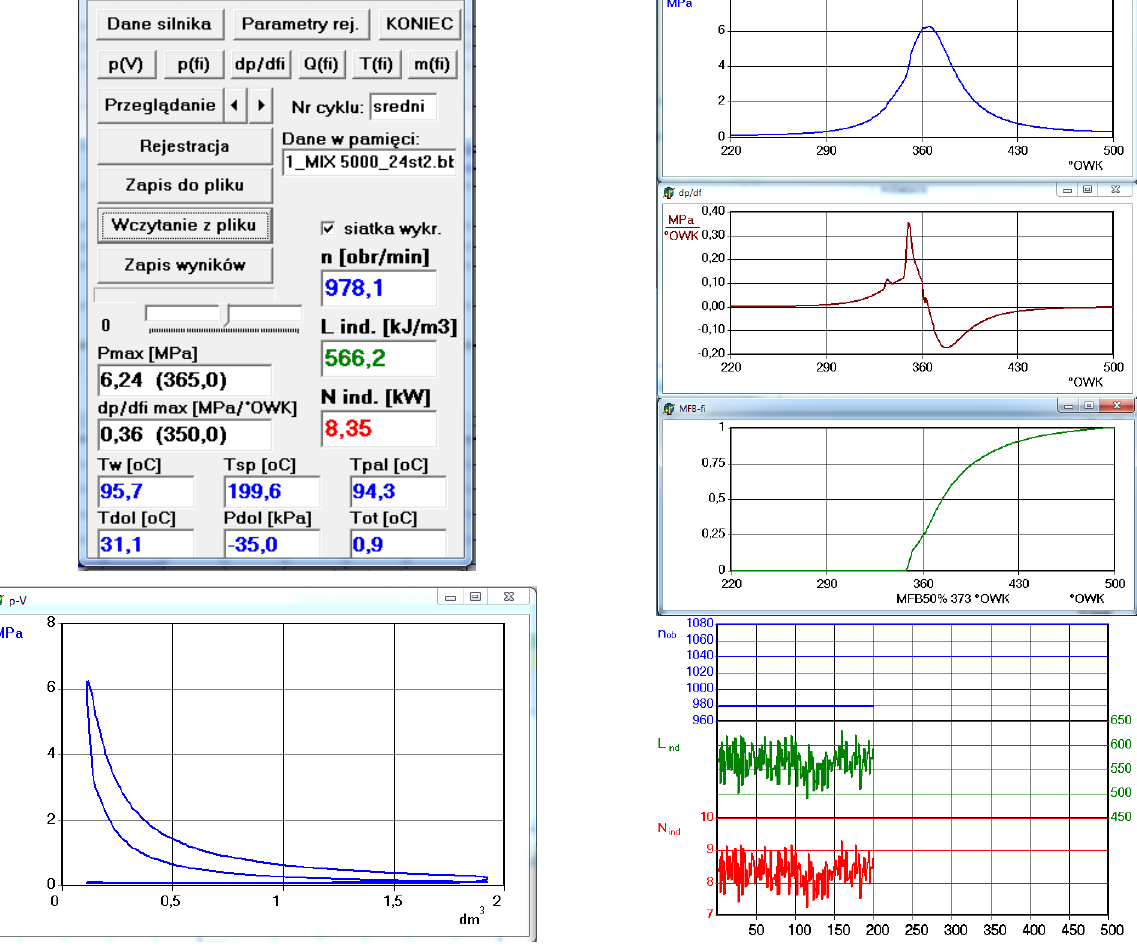
Fig. 4. View of the SAWIR program graphical interface and